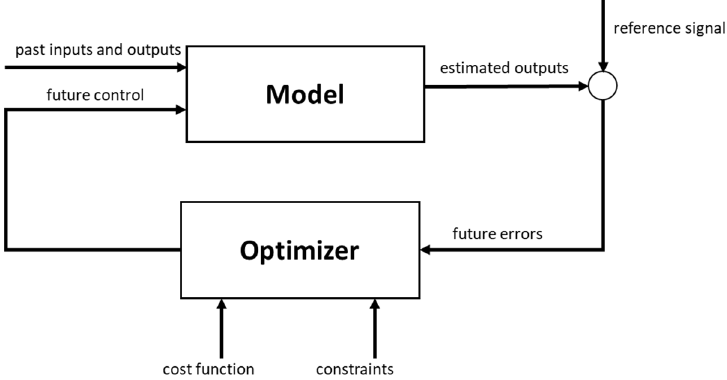
Figure 2. MPC design.